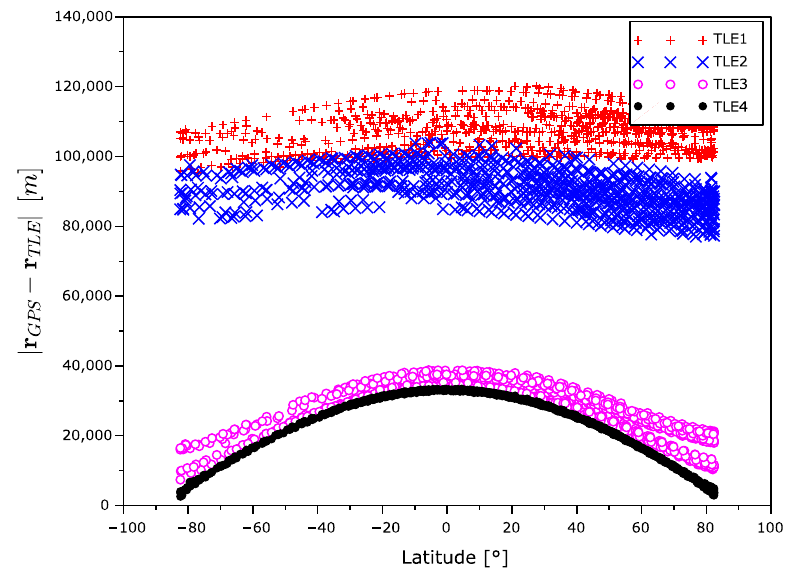
Figure 6. Position error magnitude as a function of latitude. The position error vectors primarily calculated in ECEF frame were transformed to the Hill frame (Figures 7–9), also known as the local-vertical, local-horizontal LVLH frame (Figure 10). The Hill frame is a local frame with the x h coordinate perpendicular to the reference ellipsoid, the y h coordinate laying in orbital plane, and the z h coordinate perpen- dicular to the x h y h plane forming a right-handed orthogonal system. The transformation from the ECEF to the Hill frame can be done in three steps. (1) Transformation to the ENU (east, north, up) coordinates. (2) Rearrangement of the order of the coordinates. (3) Rotation around x h axis of the course over ground. The rotation angle can be calculated from the velocity vector, for instance.